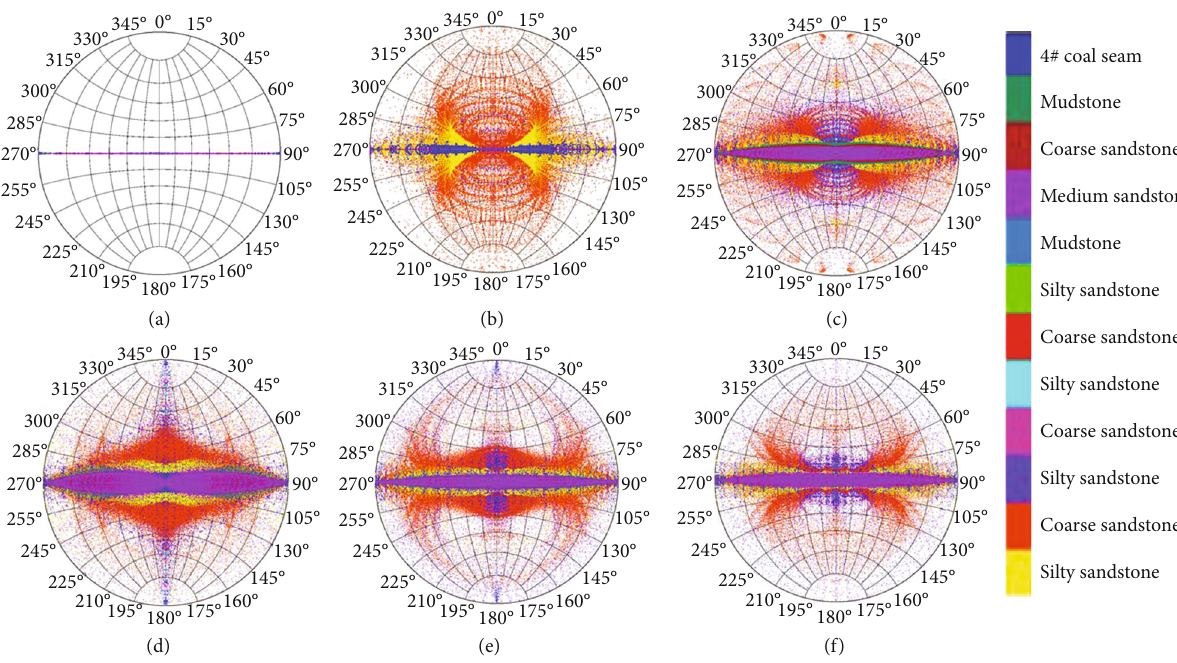
Figure 7: Evolution track of principal stress direction under dynamic load disturbance. (a) Before dynamic load disturbance; (b) dynamic load disturbance 0.01s; (c) dynamic load disturbance 0.03s; (d) dynamic load disturbance 0.05s; (e) dynamic load disturbance 0.07 s; (f) dynamic load disturbance